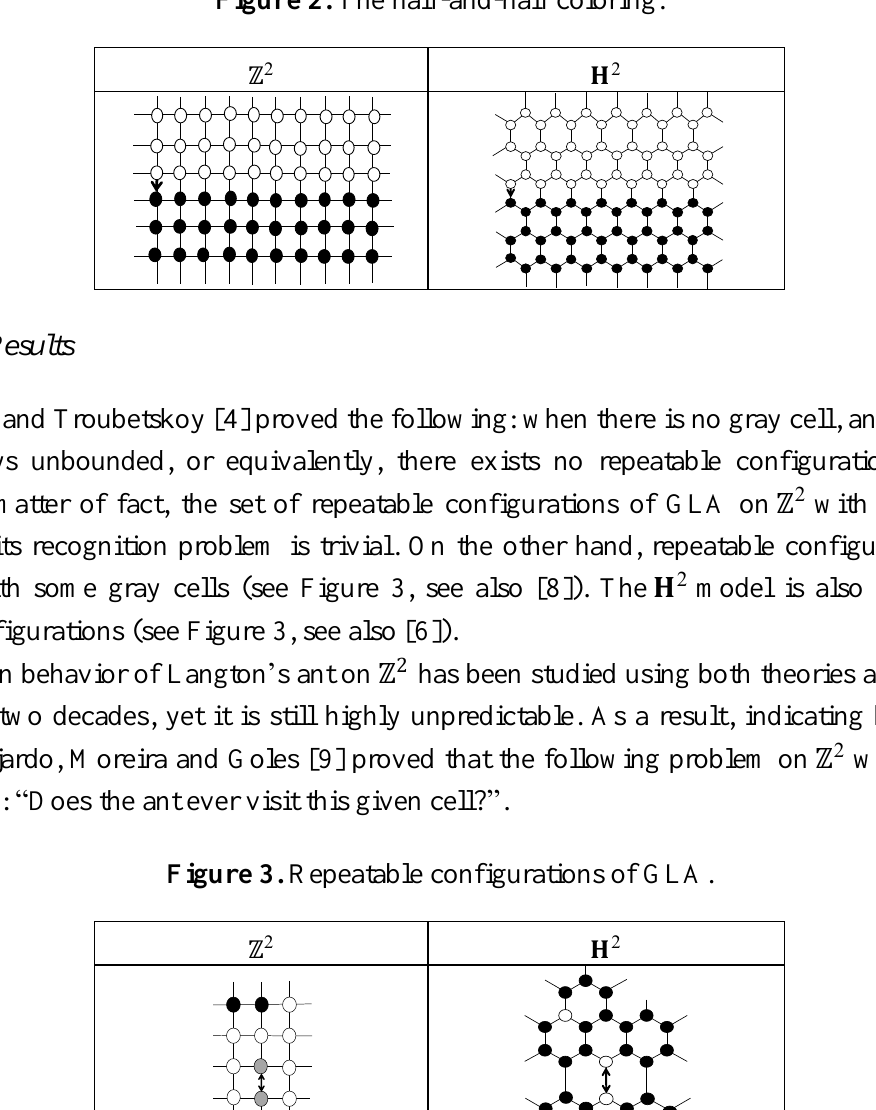
Figure 2. The half-and-half coloring.